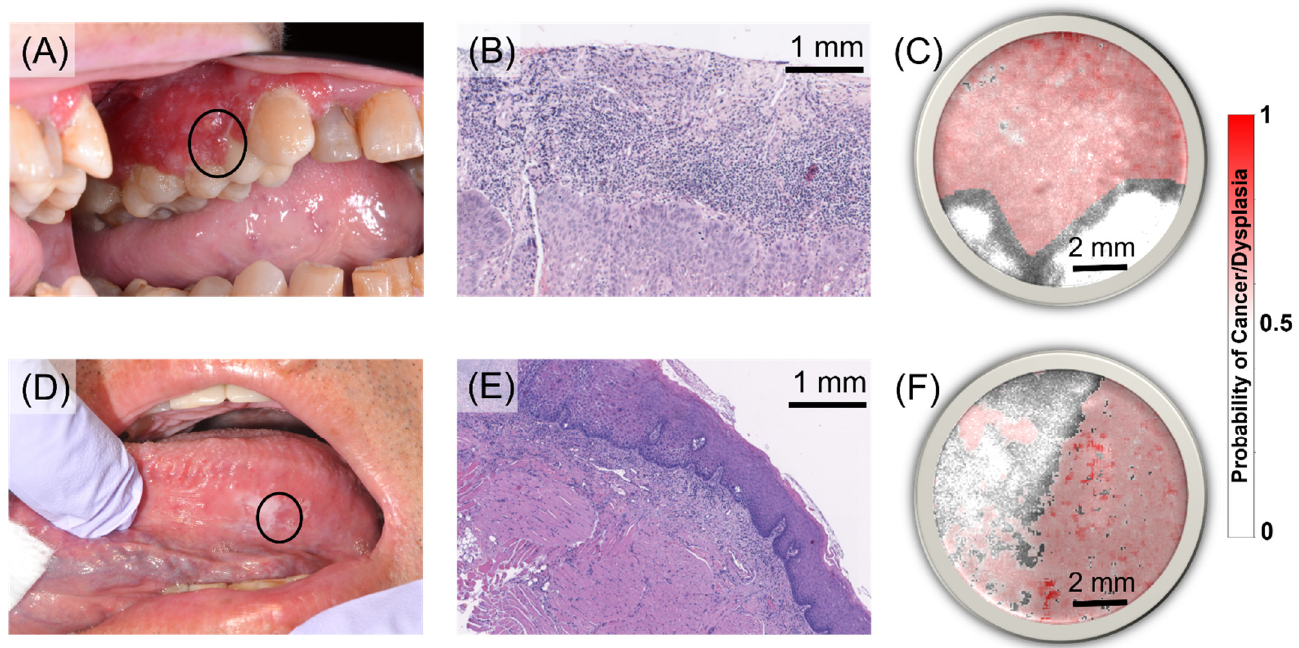
Figure 3. Representative imaged, diagnosed, and classified cancerous and precancerous oral lesions from the testing set. Top: ( A ) Red, inflamed lesion in left maxillary buccal gingiva (black circle indicates approximate location of the acquired maFLIM image FOV). ( B ) Histological examination of an incisional biopsy revealed moderately differentiated squamous cell carcinoma (SCC) (Scalebar: 1 mm). ( C ) Posterior probability map (red intensity scale) superposed on the total fluorescence intensity map (grey intensity scale) of the gingiva lesion obtained from the SVM-QDA ensemble classifier (Scalebar: 2 mm). Bottom: ( D ) White plaques in left lateral ventral tongue. ( E ) Histological examination of an incisional biopsy revealed mild-to-moderate epithelial dysplasia (MoD) (Scalebar: 1 mm). ( F ) Posterior probability map (red intensity scale) superposed on the total fluorescence intensity map (grey intensity scale) of the tongue lesion obtained from the SVM-QDA ensemble classifier (Scalebar: 2 mm).